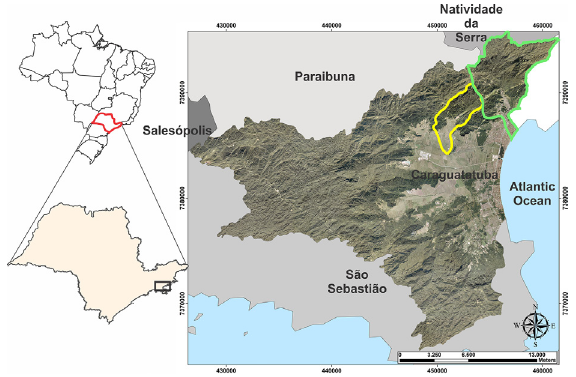
Figure 1 - Location of the study area. The aim of study is located in the yellow (Canivetal River Basin) and green (Santo Antônio River